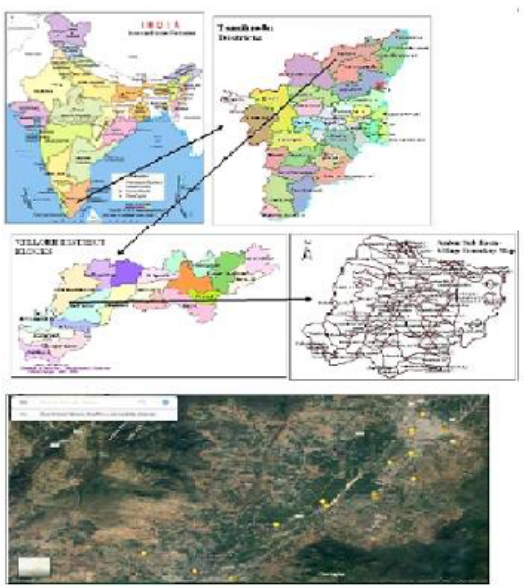
Figure 1. Map of study area (Ambur